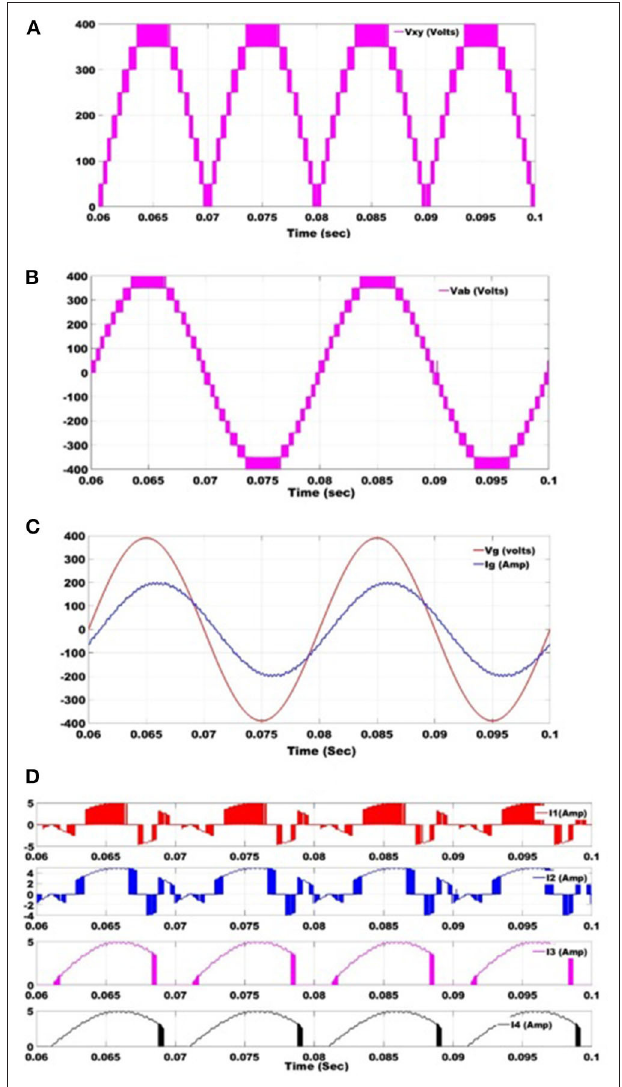
FIGURE 10 | The simulated waveforms of the grid connected bi-directional seventeen level inverter topology at power factor of 0.95; (A) output voltage of the level generation circuit (V XY ); (B) output voltage (V ab ); (C) voltage across the grid and current through the grid (Grid current is scaled up 70 times to